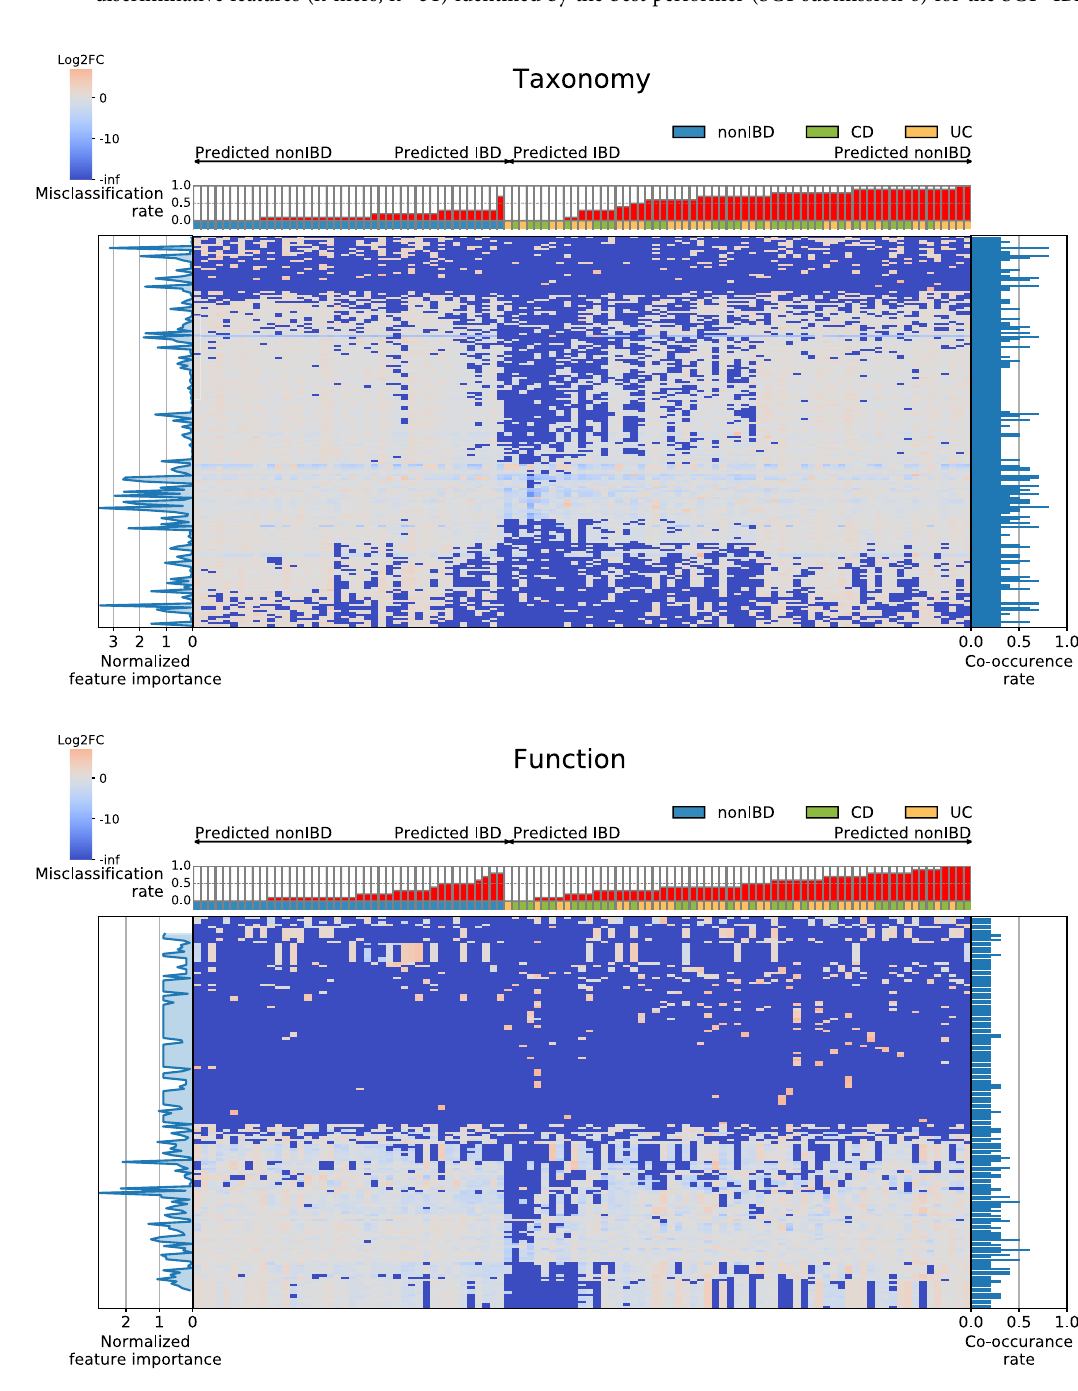
Figure 6. Log2-fold change abundance of the consensus signature features in the test samples. Results for Taxonomy and Function data types are shown separately. Samples are sorted first per label (nonIBD or IBD) and then based on the misclassification rate within each sample